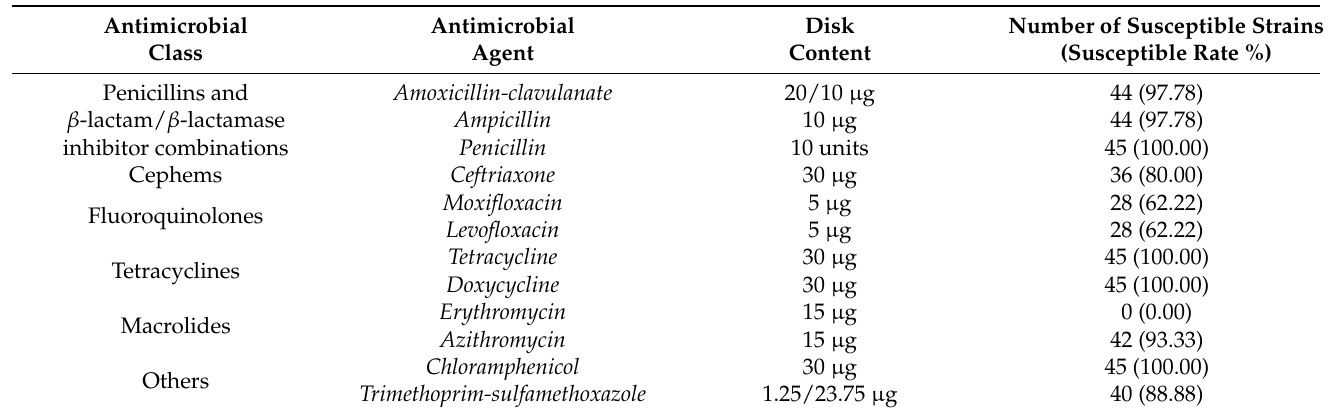
Table 1. Susceptibility rate of antimicrobials in P. multocida isolated from cafe cats.